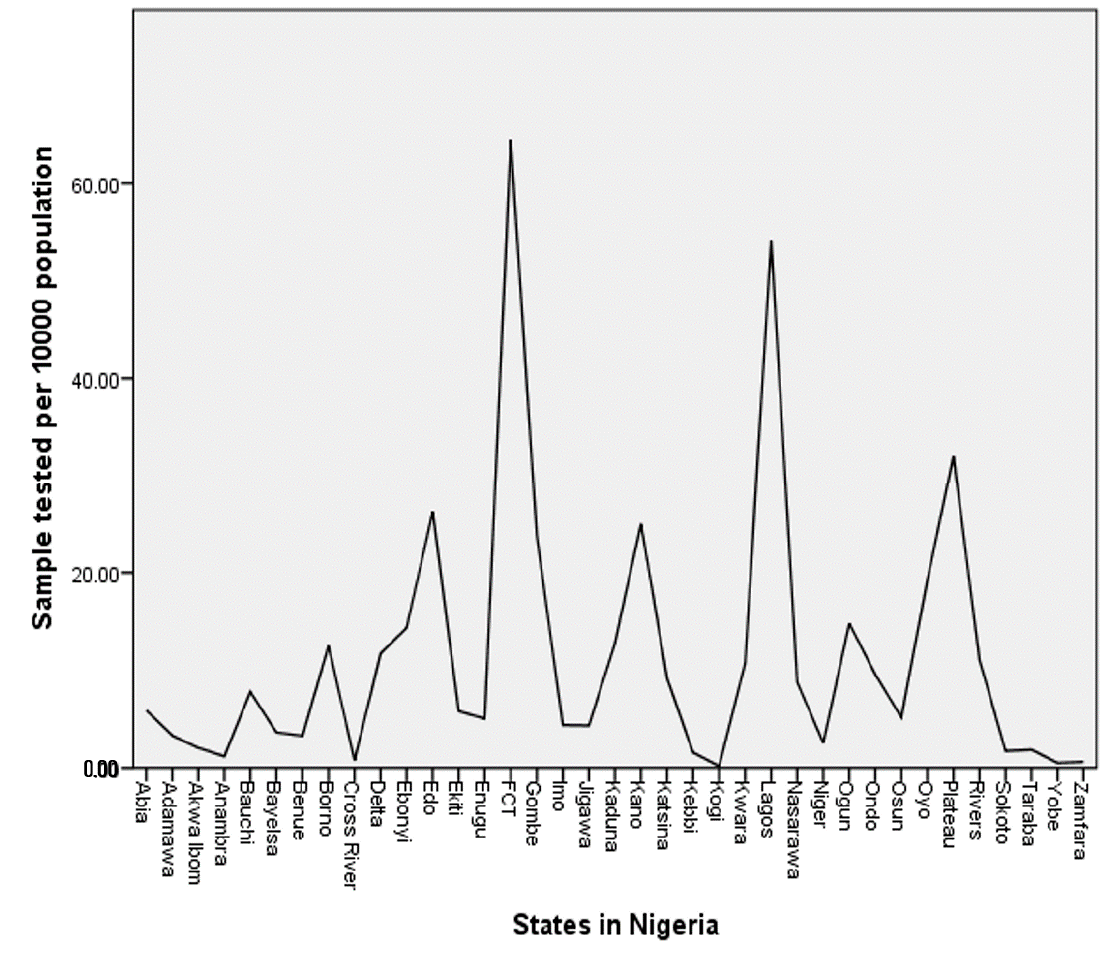
Figure 2. COVID-19 test rates per 10,000 population of each state and the FCT in Nigeria.